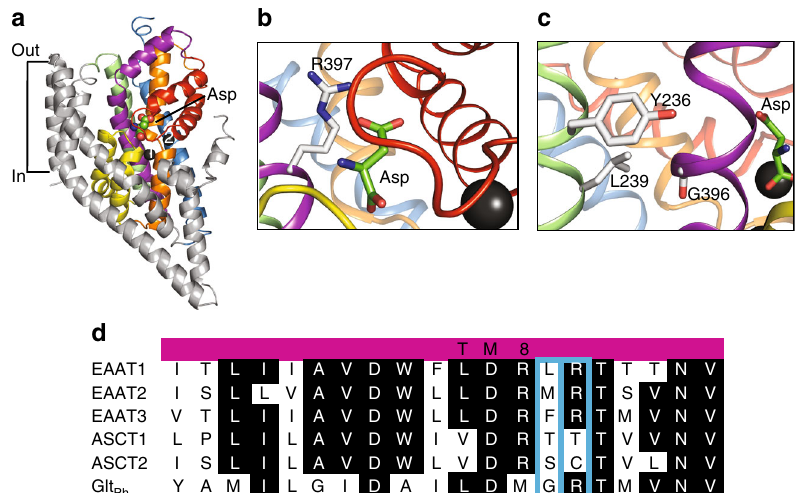
Fig. 1 The structure of a Glt Ph protomer, and sequence alignments of ASCTs and EAATs and Glt Ph a Glt Ph protomer (PDB: 2NWX) shown in the plane of the membrane, with the trimerization domain (TM1, 2, 4 and 5) in grey and the transport domain: TM3 (blue), TM6 (green), TM7 (orange), TM8 (purple), HP1 (yellow) and HP2 (red). L-Aspartate and two bound Na + ions (dark grey spheres) are shown. Close-up view of the substrate-binding site is shown with b R397 and c Y236, L239 and G396 shown in stick representation. In c , the protein has been rotated for better visualisation of the TM3 and TM6 interface. Images were made using Pymol 64 . d Sequence alignment of part of TM8 in EAAT1-3, ASCT1-2 and Glt Ph , where conserved residues are highlighted in black, and mutated residues are highlighted by blue